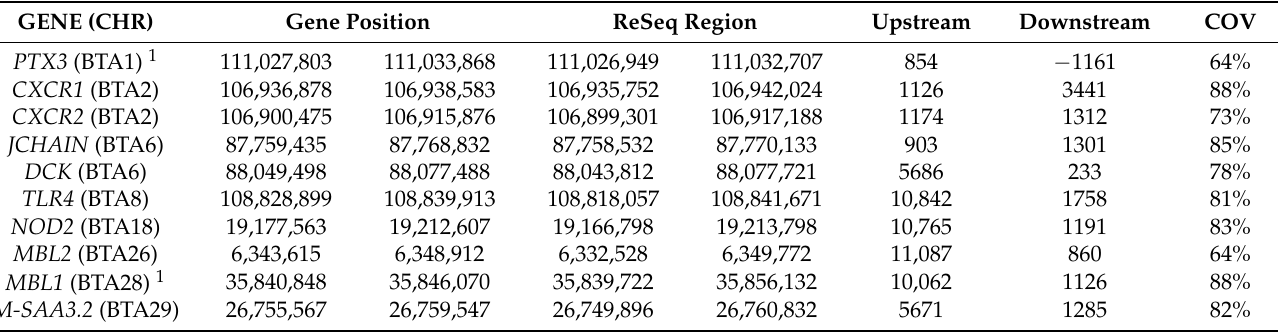
Table 1. Position of the selected genes on UMD bovine genome 3.1.1, target region selected for resequencing, genes’ upstream and downstream regions sequenced, and gene sequencing coverage